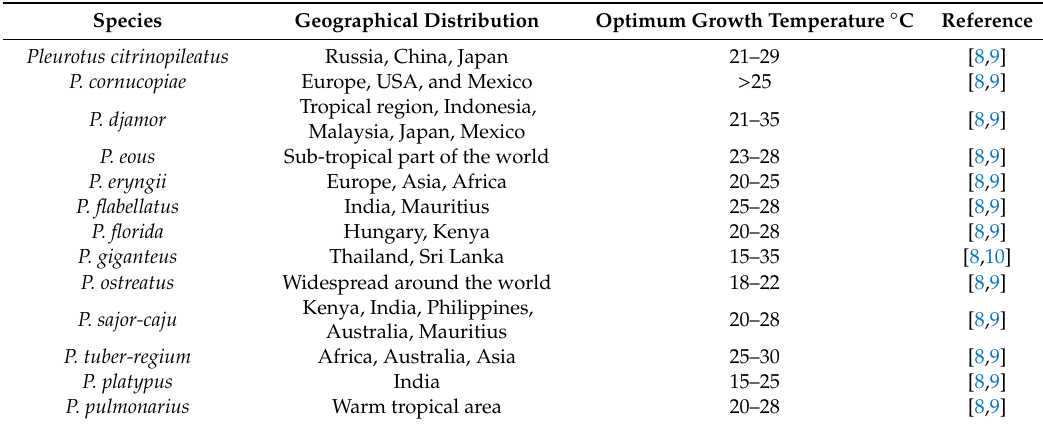
Table 1. Geographical Distribution of Pleurotus